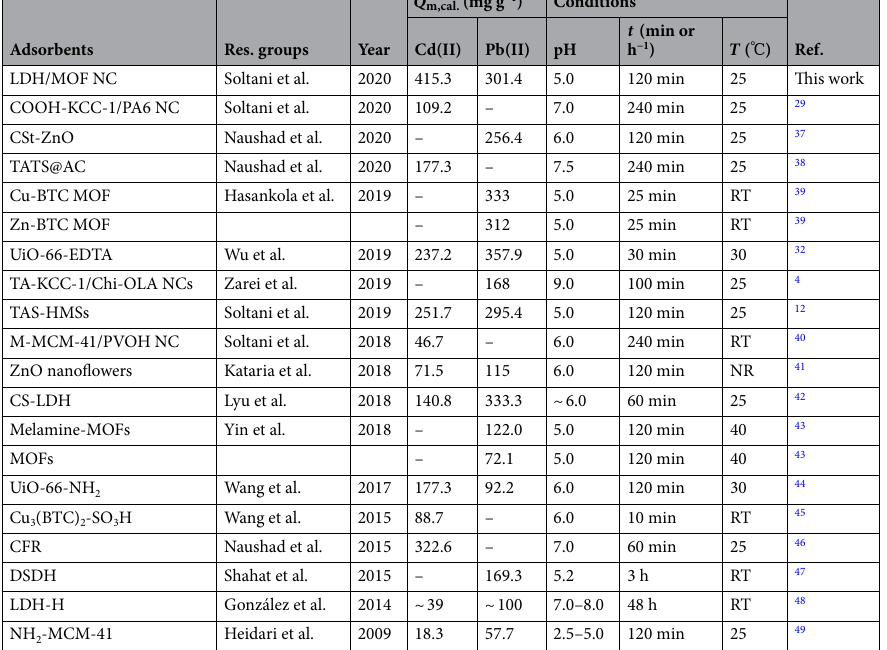
Table 4. Adsorption capacities for Cd(II) and Pb(II) by various LDH-based and MOF-based adsorbents as well as the other nanoporous adsorbents ( RT room temperature, NR not reported). COOH-KCC-1/PA6